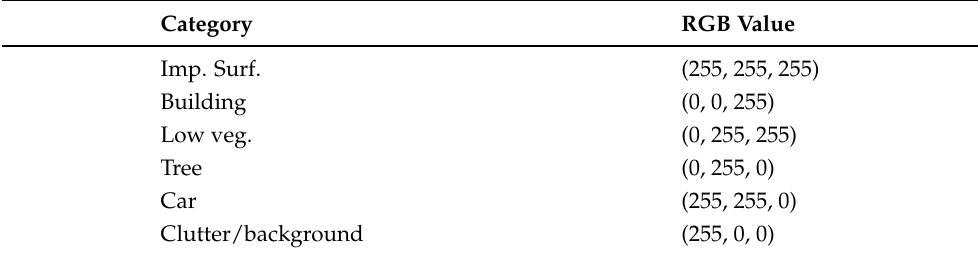
Table 2. RGB values of the